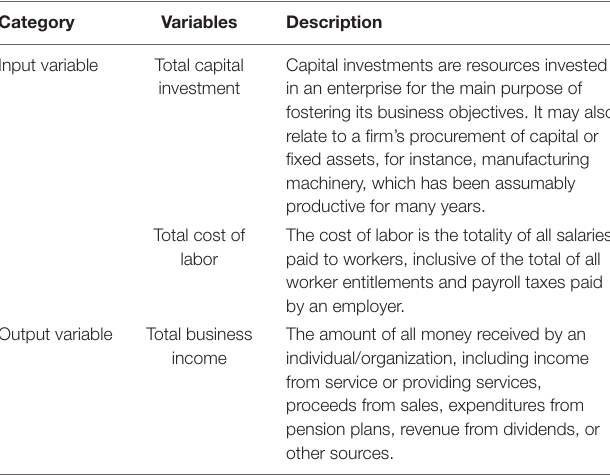
TABLE 1 | Variable description.